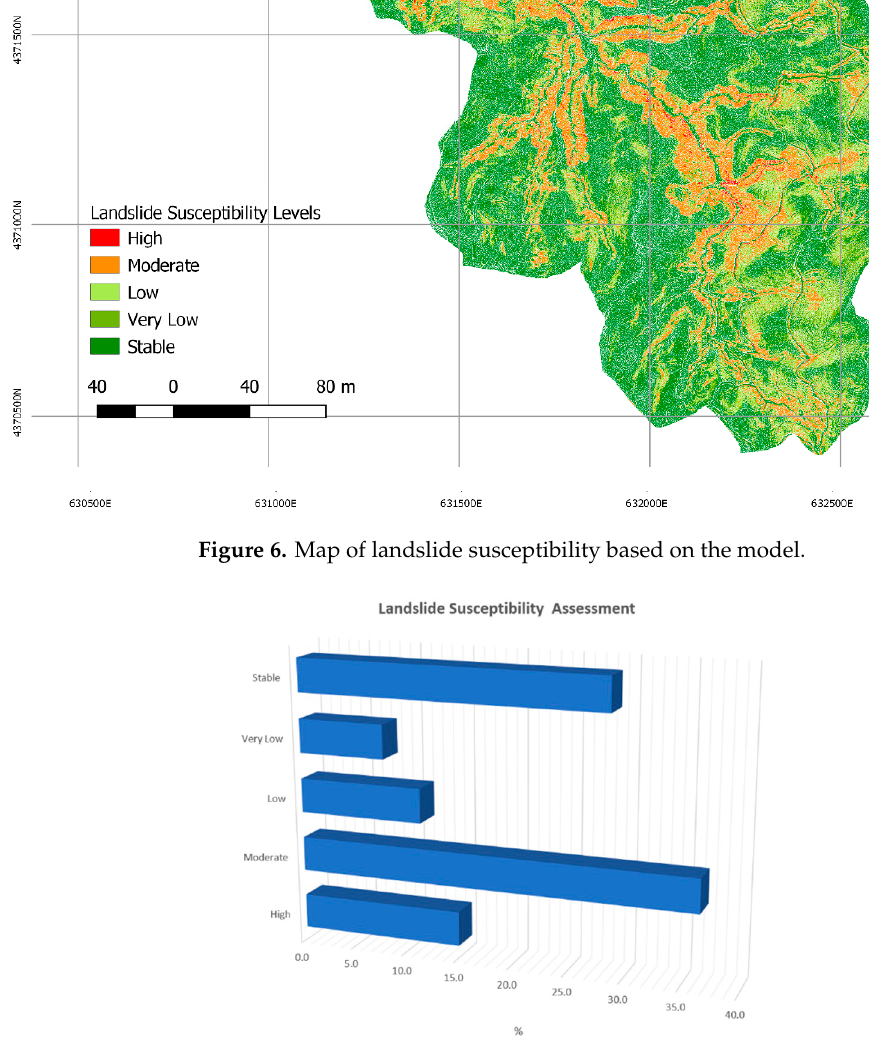
Figure 7. Percentages of catchment area partitioned in five categories of landslide susceptibility based on modelling results.